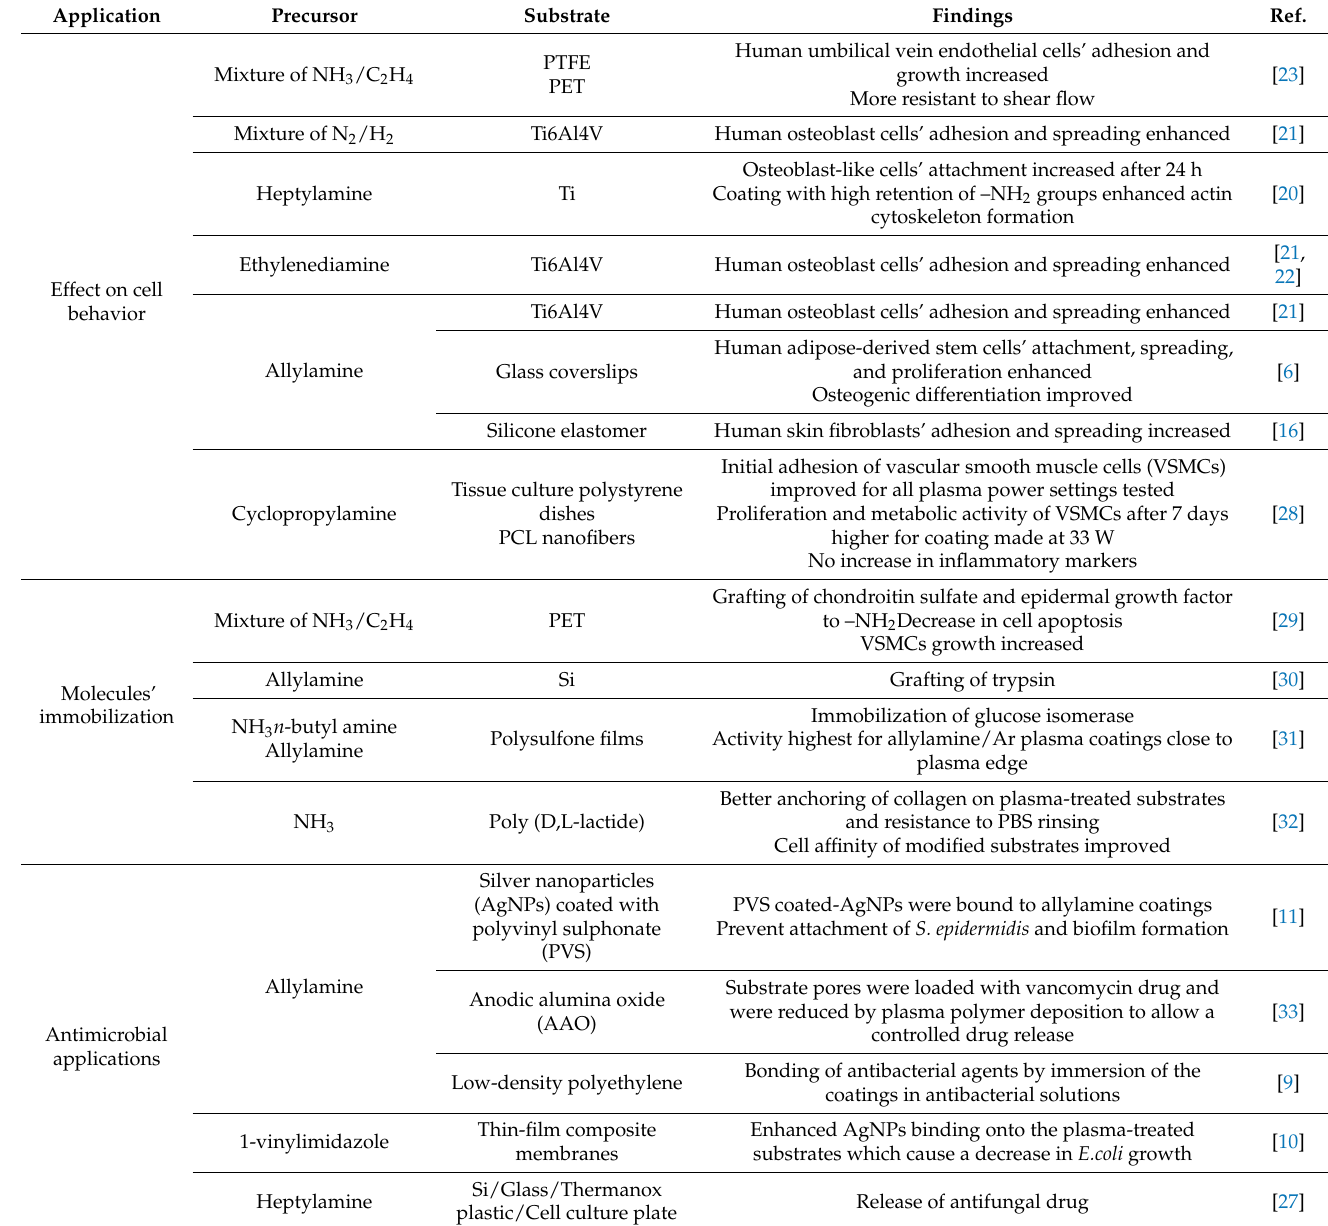
Table 1. Overview of different applications of amine-rich coatings obtained by plasma and the findings associated. Application Findings